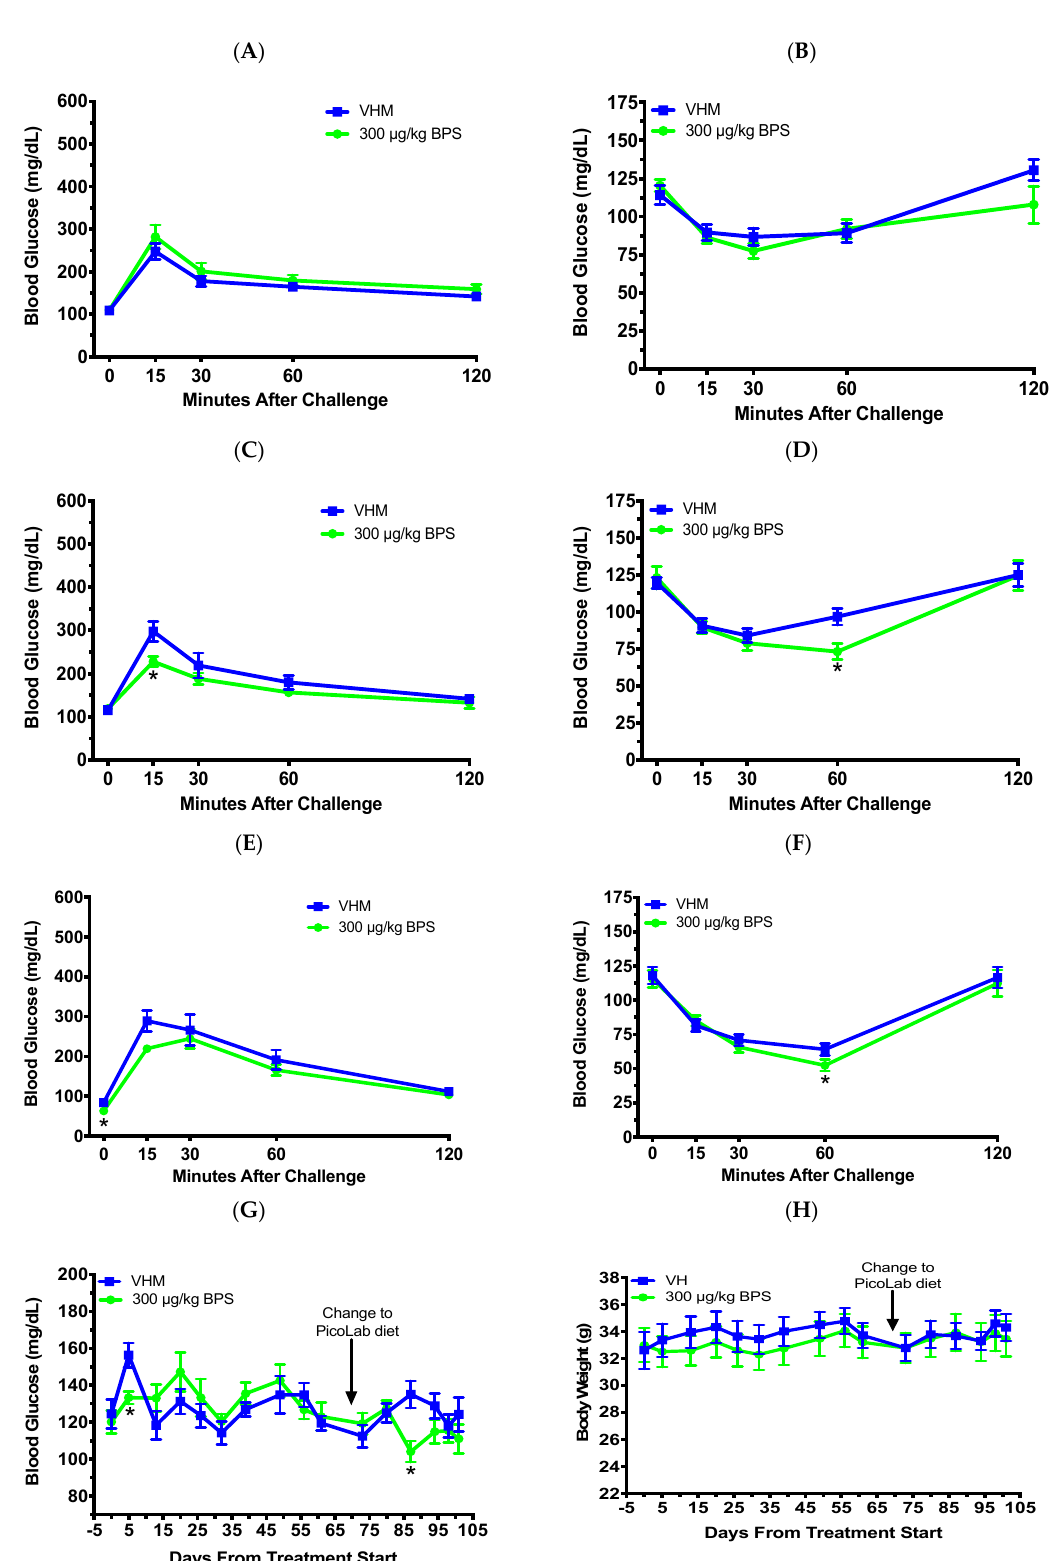
Figure 5. Tolerance tests, BGLs and body weight in male NOD mice initially on a phytoestrogen-free diet for 70 days and then switched to the soy-based diet for another 31 days. Glucose tolerance test (GTT) and insulin tolerance test (ITT) were conducted after BPS exposure for one month ( A : GTT; B : ITT), 2 months ( C : GTT; D : ITT) and 3 months ( E : GTT; F : ITT). ( G ) Time course of non-fasting BGLs. ( H ) Changes in body weight over time. The values are presented as mean ± SEM. *, p < 0.05. N = 7–10. VHM, vehicle males.